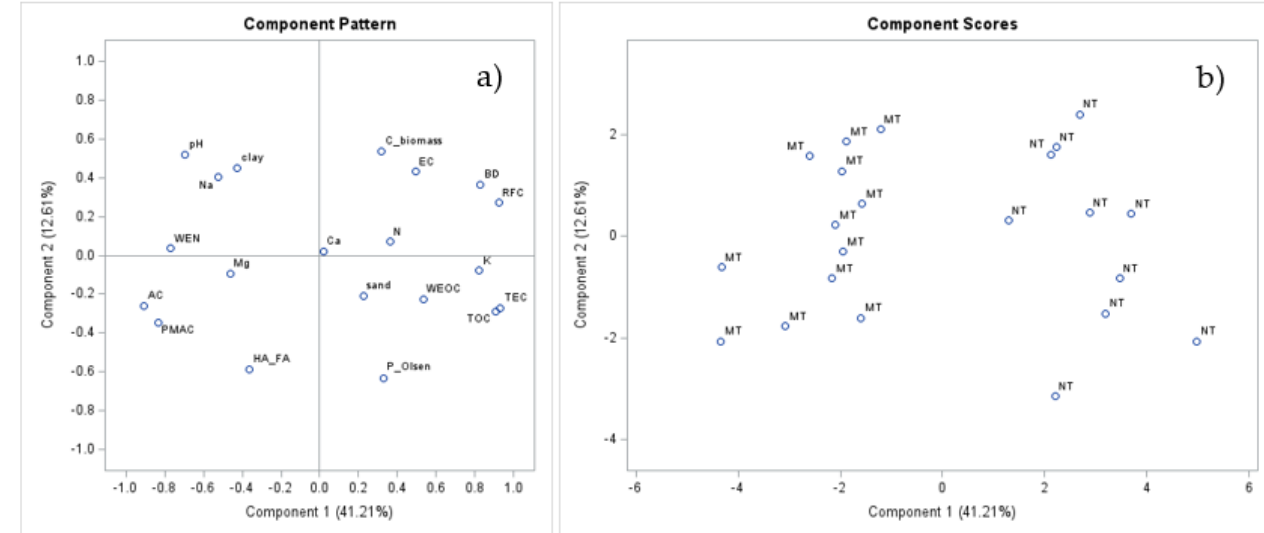
* indicates the significance of the variable loadings. The sign of variable loadings indicates the